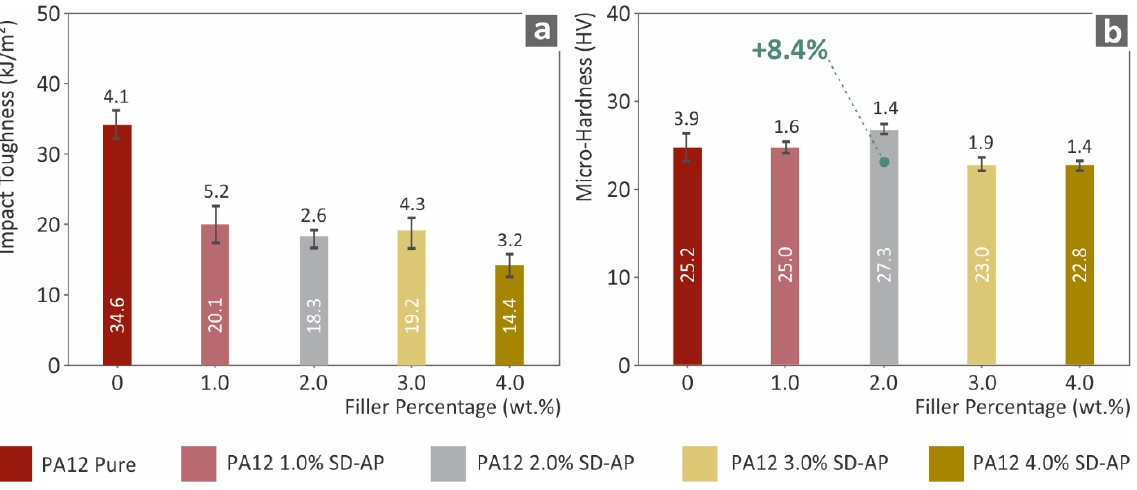
Figure 6. ( a ) Impact toughness (kJ/m 2 ) to filler ratio; ( b ) Vickers microhardness (HV) to filler loading.